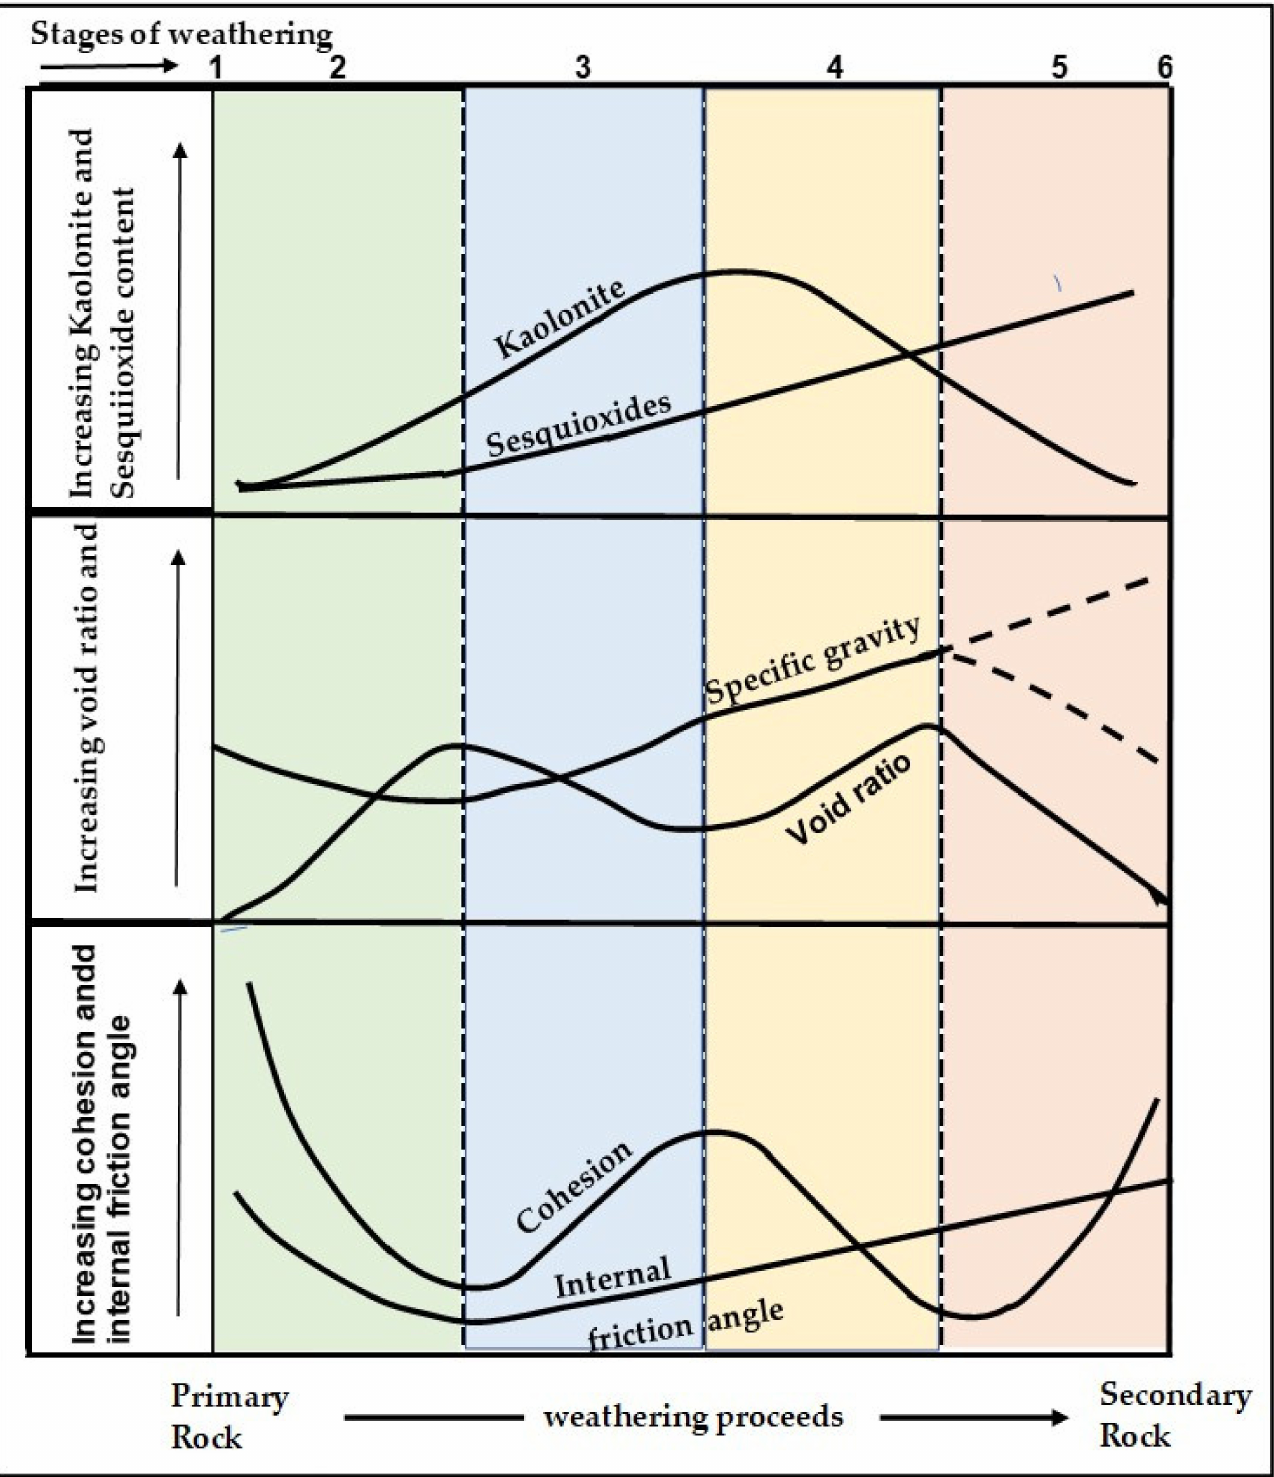
Figure 11. A model for variation in engineering properties of basalt derived lateritic soils resulting from weathering (Recreated from